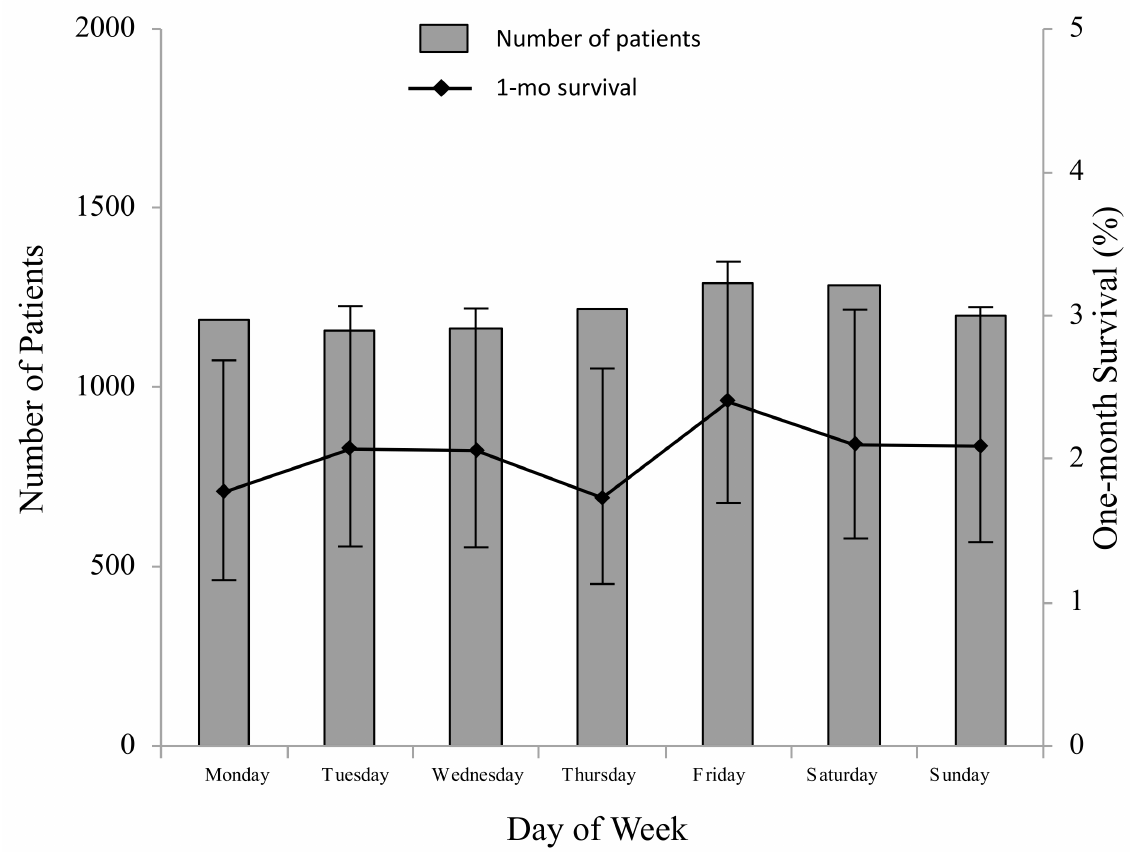
Figure 3. Number of patients and rate of one-month survival by day of week. No difference was observed in one-month survival between the days of the week ( p = 0.9273).